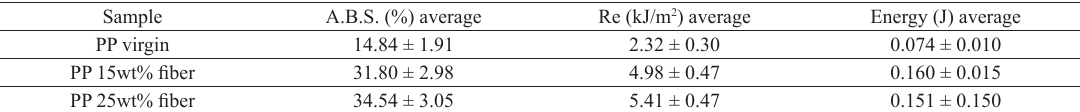
Table 7. Impact resistance results, notched specimens. Sample